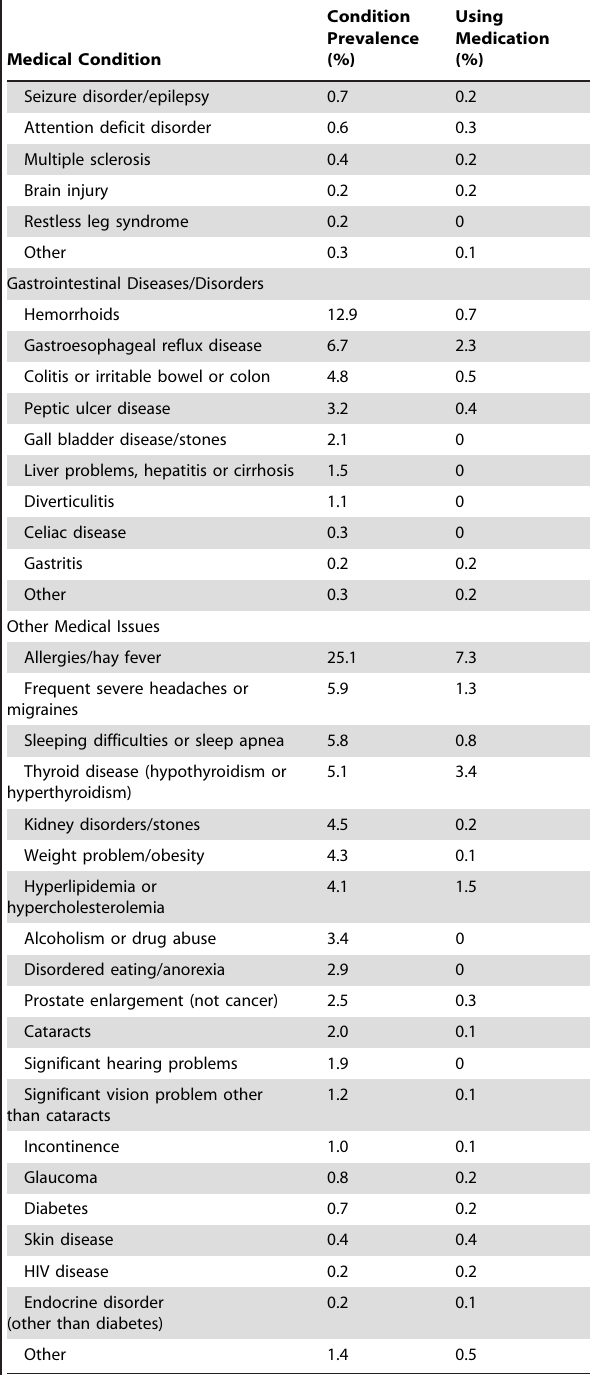
Table 1. Point prevalence of various medical conditions among 1,212 active ultramarathon runners and the proportion who were using relevant medications.